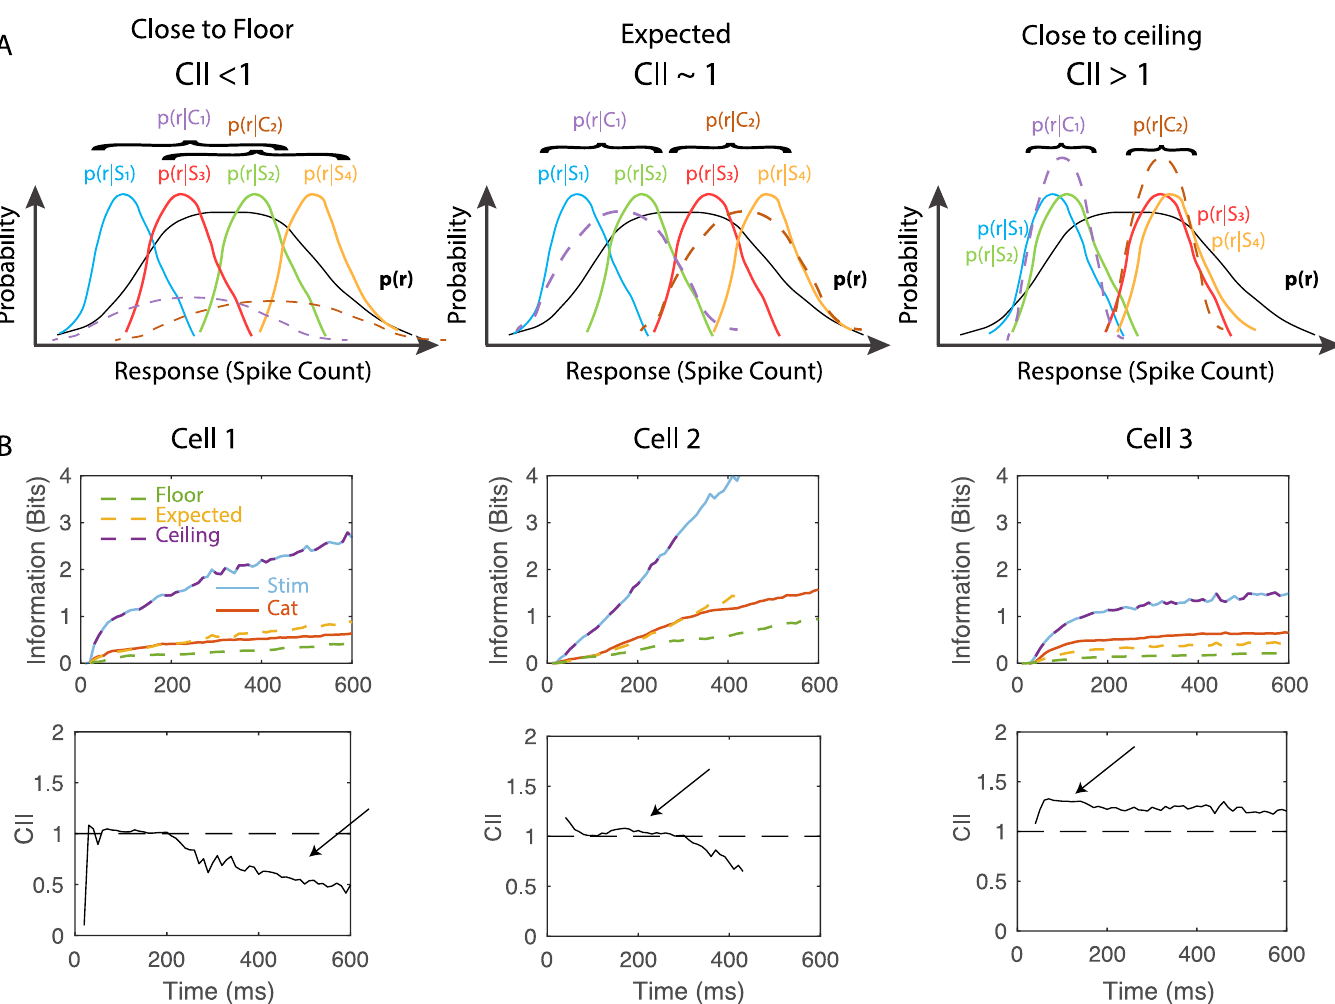
Fig 8. Cumulative information and the categorical information index. A . Schematic of hypothetical response probability distributions that yield different values of the Categorical Information Index (CII). CII is defined by comparing the cumulative categorical information to a floor (CII = 0), an expected value predicted from the stimulus information (CII = 1) and a ceiling value (CII = 2) as described in the text and methods. Each plot represents the distributions of hypothetical neural responses for different stimuli (S1 to S4) that yield different values of CII. When stimuli are grouped randomly into categories (S 1 and S 2 belong to C 1 , while S 3 and S 4 belong to C 2 ), CII is close to 0 (left panel). When stimulus categories preserve the order of the stimulus conditioned response distributions and these distributions are equally separated, effectively coding for both stimuli and categories, CII is equal to 1 (middle panel). When stimuli belonging to the same category have identical responses, the stimulus information is equal to the category information, the response being effectively invariant within categories and CII is equal to 2 (right panel). Note that the actual response probability distributions are multidimensional (one dimension for each time lag) with Poisson marginals. B . Example of the cumulative information for stimuli and call- type categories and CII for 3 different representative neurons. The blue and red lines are the cumulative information for stimuli and categories respectively. Estimates of the floor (dashed-green), expected (dashed-orange) and ceiling (dashed-purple, here overlapping with blue) values for the categorical cumulative information as described in A are given as well. The CII is shown as a solid line in the second row for each example neuron. Cell 1 has long periods of time with CII < 1, Cell 2 has long periods of time with CII ~ 1 and Cell 3 has long periods of time with CII > 1 as shown by the